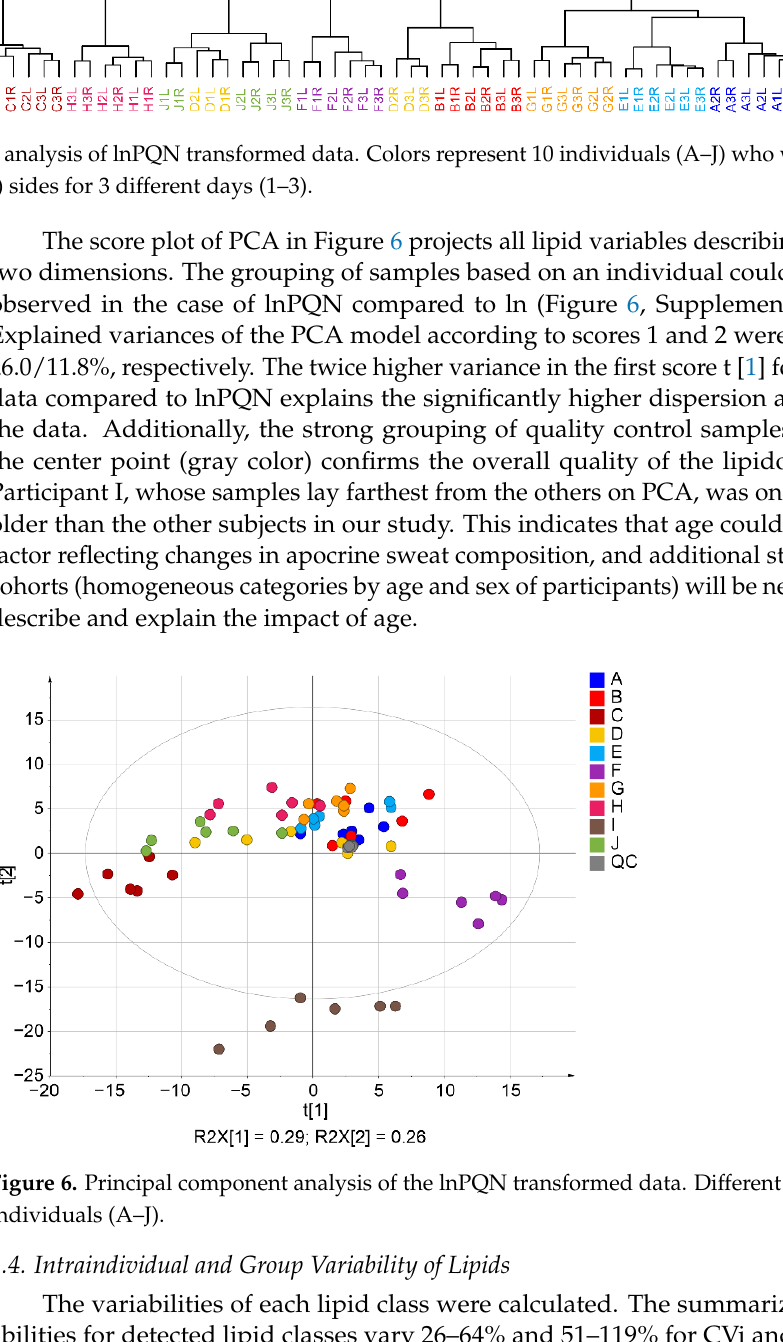
Figure 6. Principal component analysis of the lnPQN transformed data. Different colors represent 10 individuals (A–J).